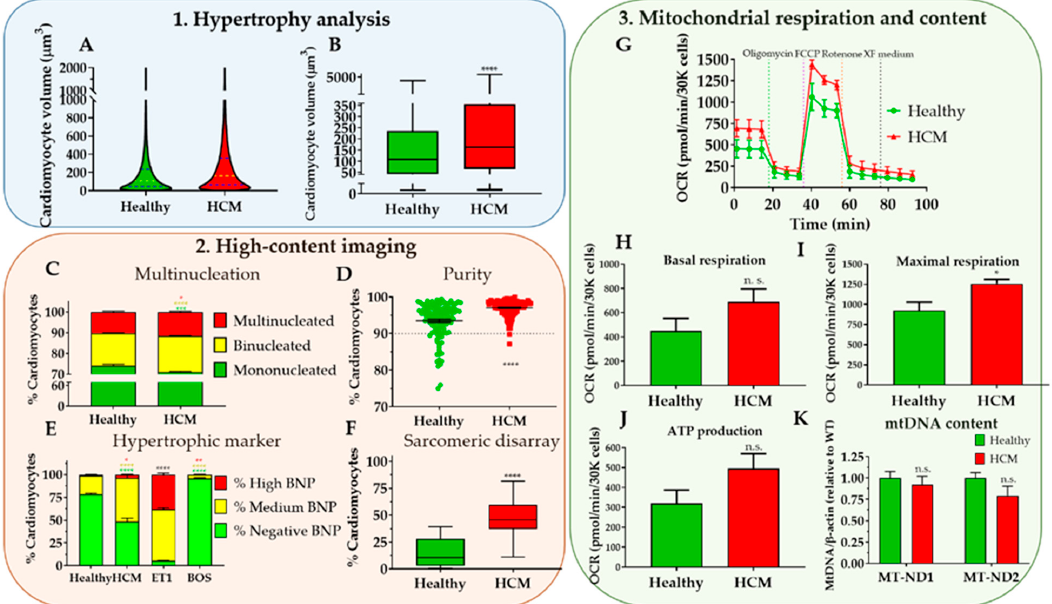
Figure 8. Example of application of phenotyping toolkit to HCM cellular model. ( A , B ) Hypertrophy analysis by flow volumetry indicating increased median volume in HCM cardiomyocytes relative to healthy counterparts. ( C – F ) High-content imaging evaluation of HCM cardiomyocytes showing increased proportion of multinucleation, expression of hypertrophic marker BNP, and sarcomeric disarray relative to healthy controls. ( G – J ) Assessment of mitochondrial respiration in Seahorse™ assay revealing higher energy production in HCM cardiomyocytes in comparison with healthy ones, showing ( K ) similar mitochondrial DNA content (determined by ratiometric mito/nuclear DNA qPCR analysis). Data represent mean +/- SEM of five independent experiments comparing R453C- β -myosin heavy-chain hPSC-CMs (HCM) to isogenic wild-type control (healthy), with 100,000–250,000 cells analysed per sample. Statistical analysis was performed by unpaired parametric Student’s t test between HCM and Healthy conditions, with the exception of Panel E, where unpaired one-way ANOVA test was used with Dunnett’s post hoc test for correction of multiple comparisons relative to Healthy condition (n. s., non-significant; * P < 0.05; ** P < 0.01; *** P < 0.005; **** P < 0.0001, colour-coded by inter-compared category—black asterisks apply to all categories).